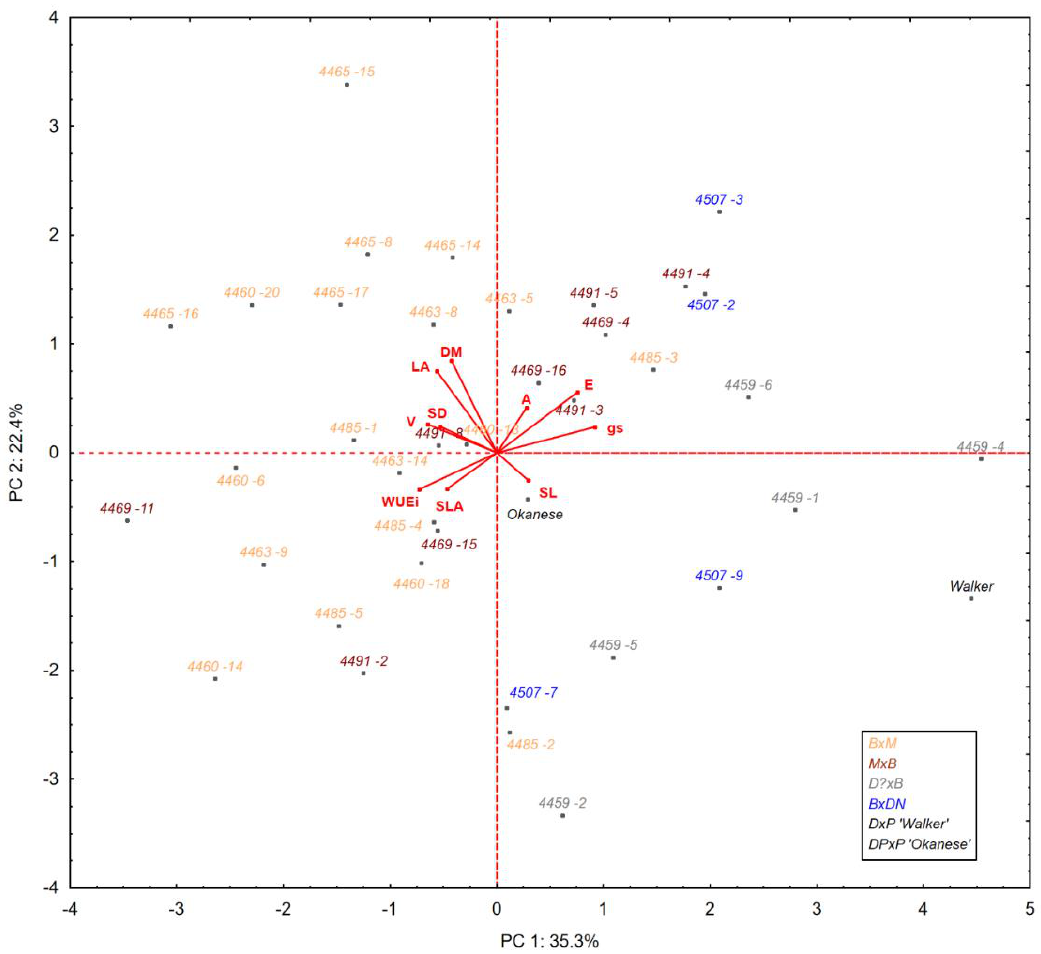
Figure 1. Principal component analysis (PCA) plot showing the multivariate variation among hybrid poplar clones for productivity, physiological, and morphological variables. Vectors indicate the direction and strength of each variable to the overall distribution. Colored clone codes correspond to the cross types represented in this study. The first two principal axes (PC 1, PC 2) explain 57.7% of the variance ( λ 1 = 3.5 and λ 2 = 2.2). The meaning of the trait abbreviations as in Table 2 footnote.